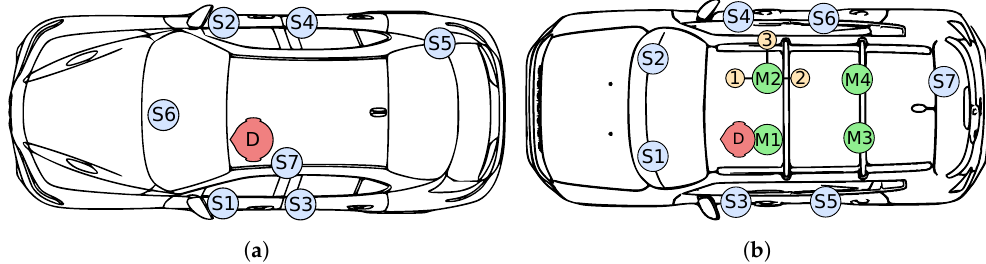
Figure 5. Top view of the Alfa Romeo Giulia ( a ) and the Jeep Renegade ( b ) showing the placement of the loudspeakers and the microphones. D indicates the dummy head. The three yellow labels S M around M2 are the proximity test microphone PM1, PM2,